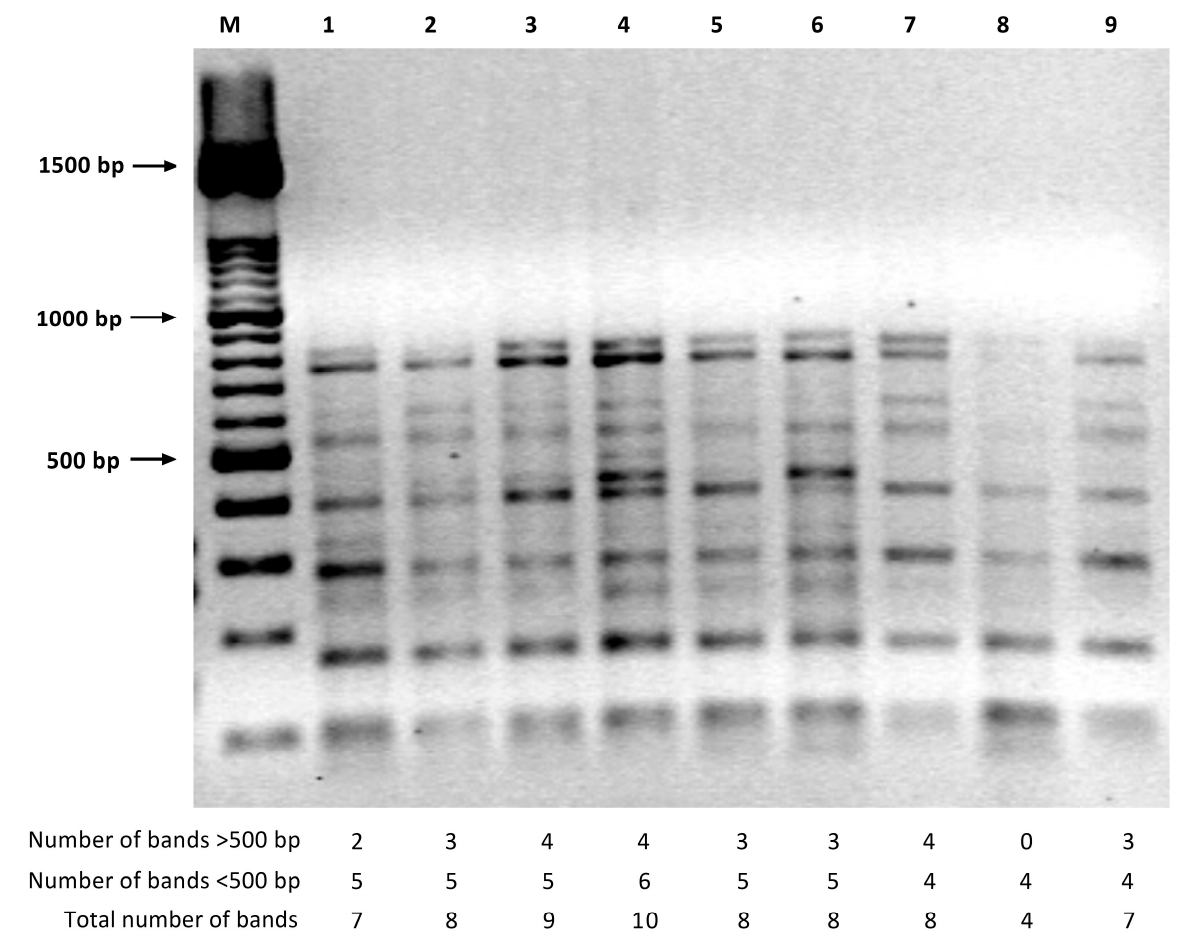
Figure 1. Amplification profiles for orthogonal array reactions performed for C. parapsilosis (F15_T1_IS_CP) and RP2 and 1247 primers. M—marker; lanes 1–9 obtained for different concen- trations of four components (MgCl 2 , dNTP, primers, DNA) prepared according to the orthogonal